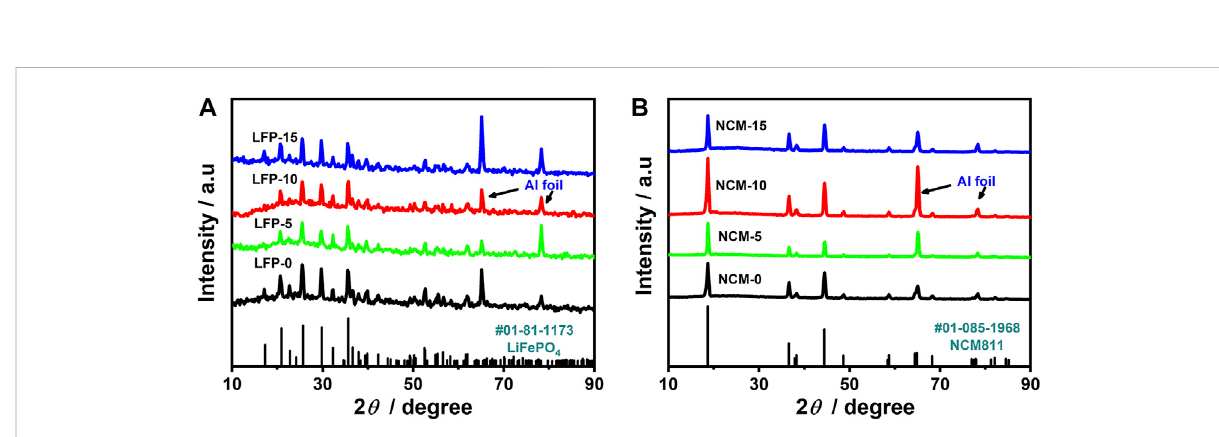
FIGURE 3 XRD curves of all electrodes: (A) LiFePO 4 electrode, LFP-0, LFP-5, LFP-10, LFP-15; (B) NCM811 electrode, NCM-0, NCM-5, NCM-10,